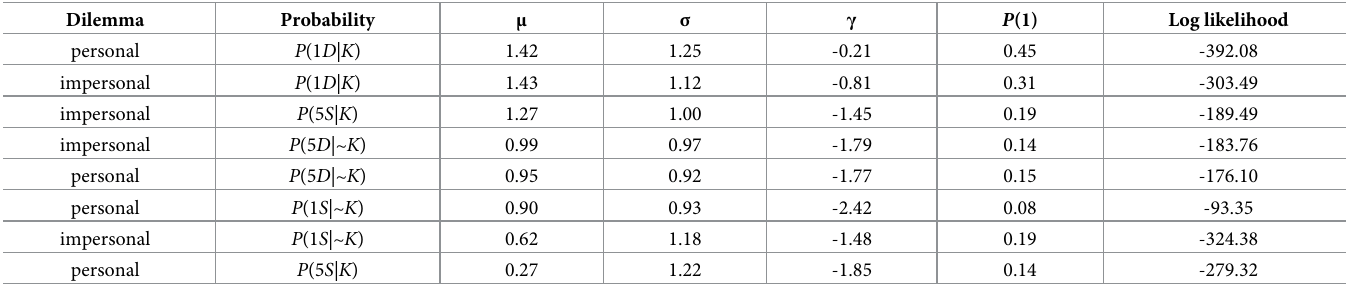
Table 2. Estimated results for the probability estimated ranked from the highest estimated mean to the lowest estimated mean.